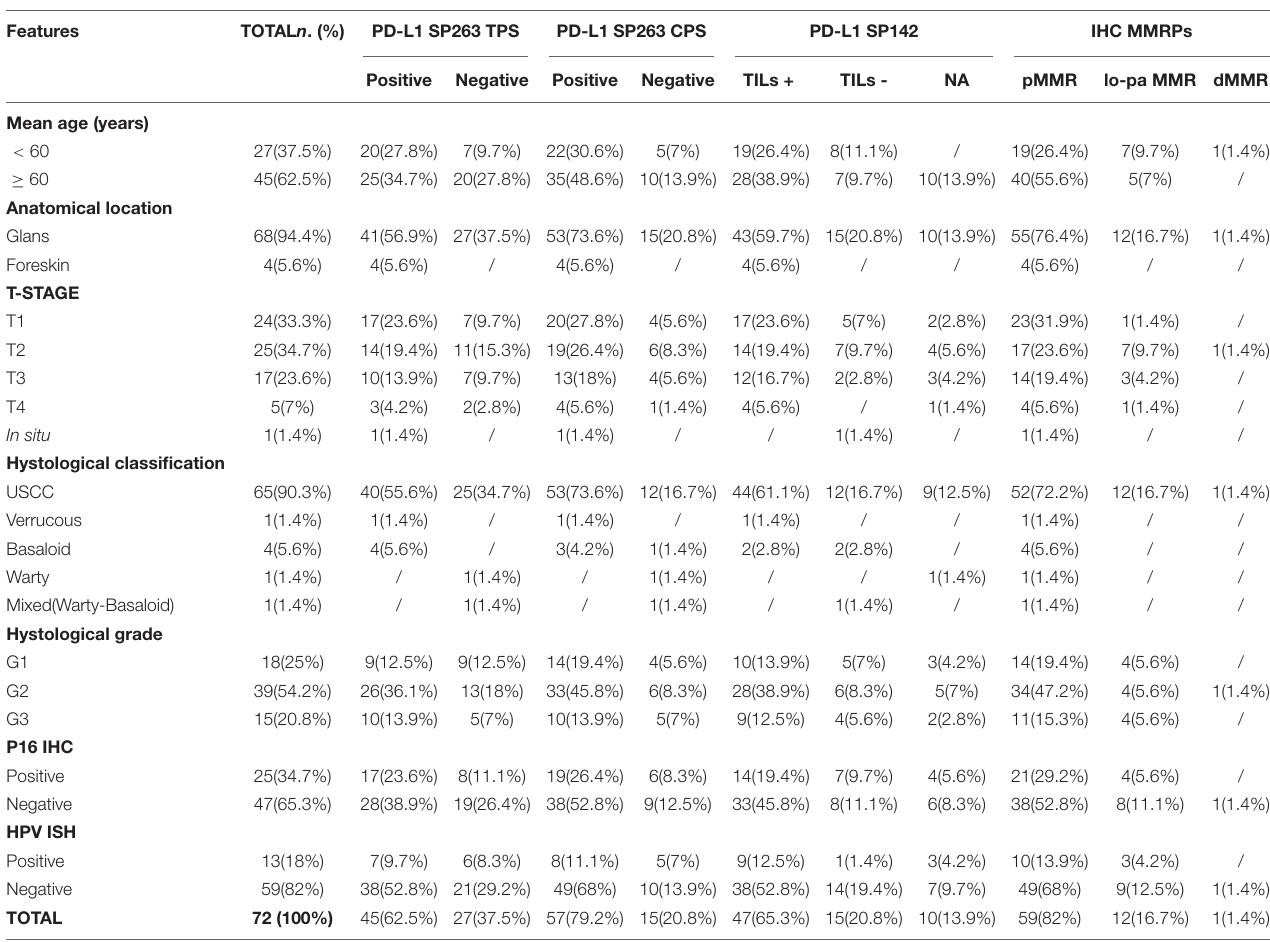
TABLE 1 | Clinical and pathological